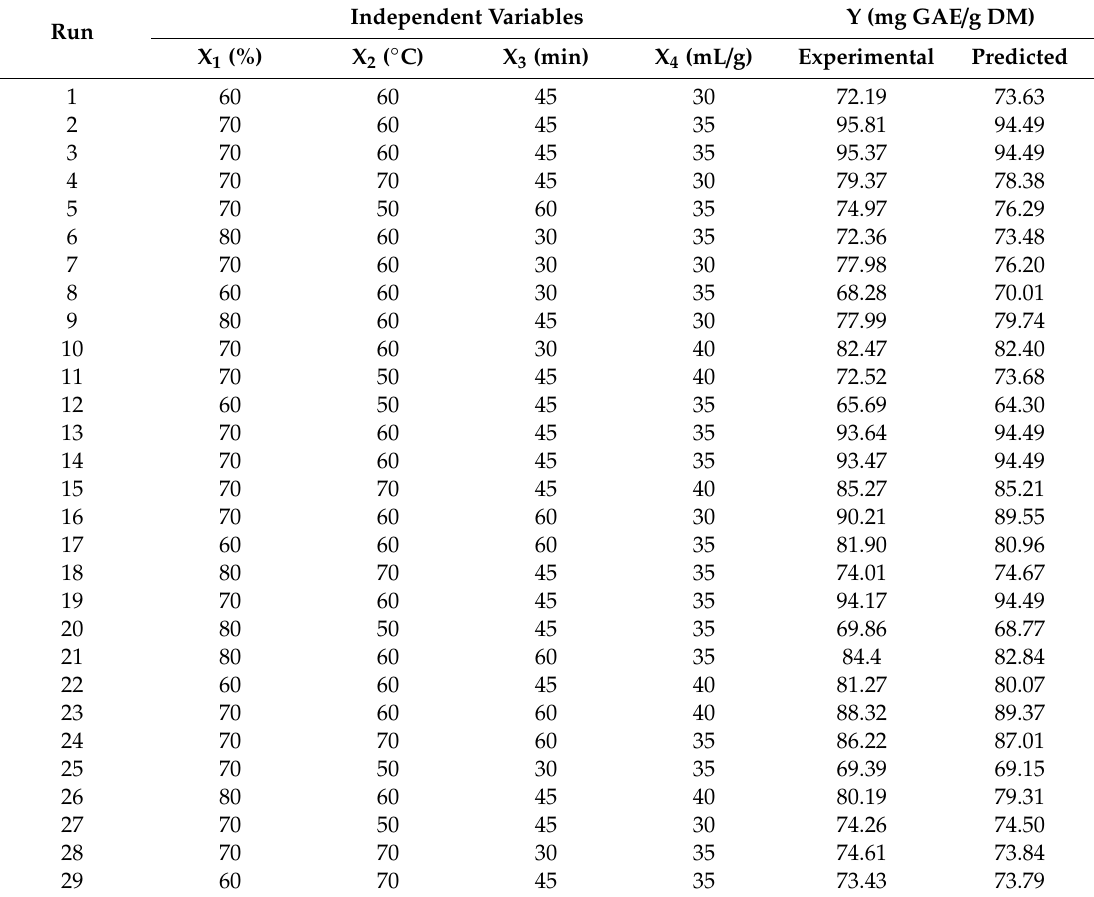
Table 1. Box–Behnken design matrix and response values for the extraction yield of total